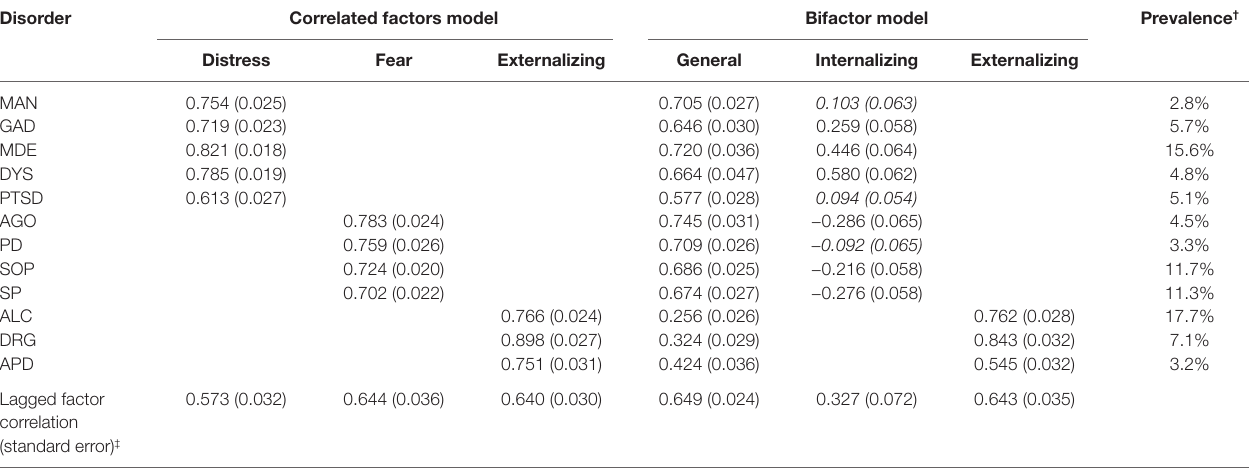
TABLE 3 | Constrained factor loadings (standard errors in parentheses) and disorder prevalence for the longitudinal correlated factors model and the longitudinal bifactor model.